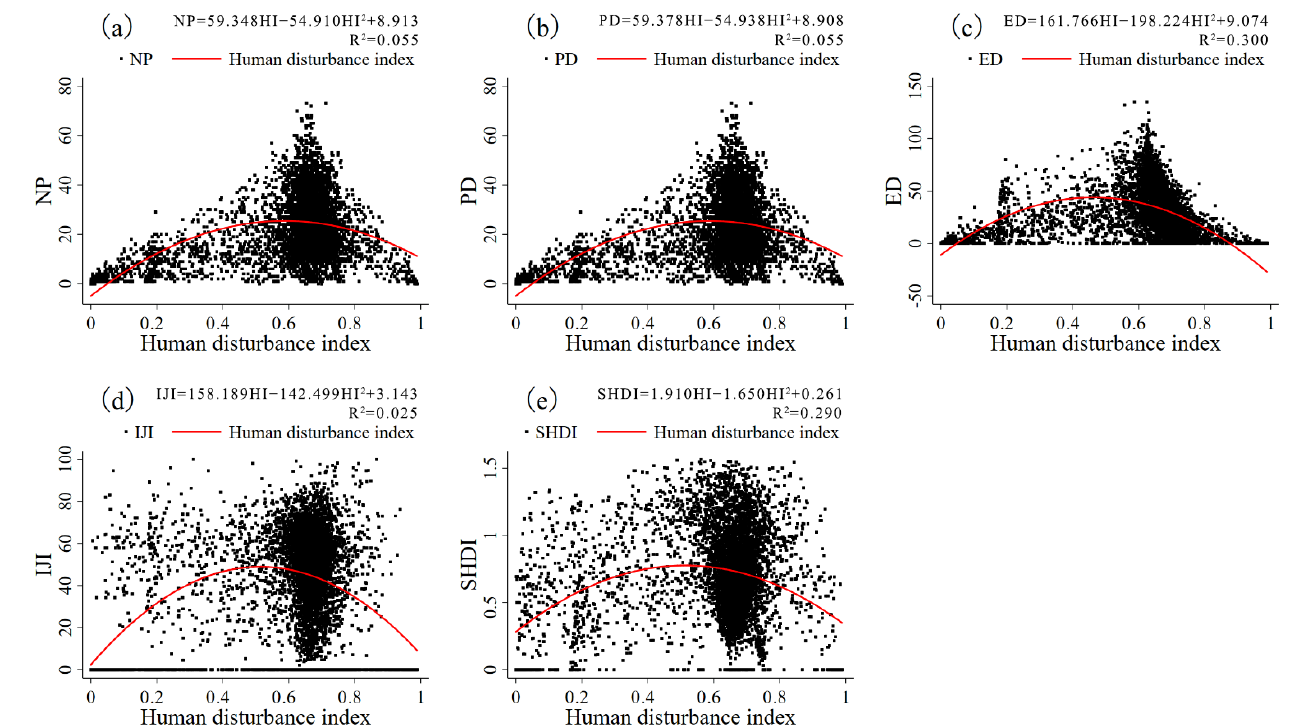
Figure 11. Relationship between the different landscape indices (( a ) NP, ( b ) PD, ( c ) ED, ( d ) IJI, and ( e ) SHDI) and human disturbance index based on the landscape level.